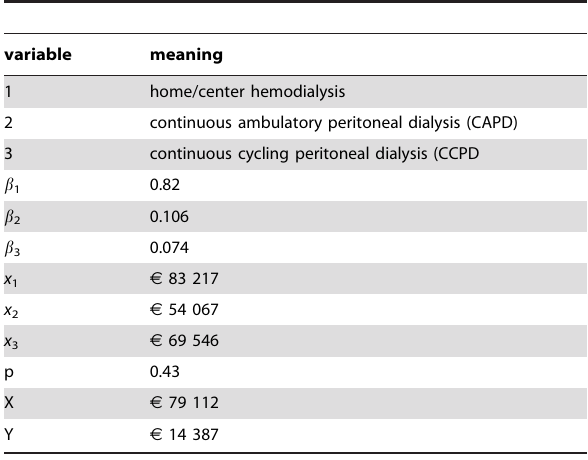
Table 2. Parameters used for calculating the cost of end- stage renal disease (see cost section under ‘‘Methods’’).